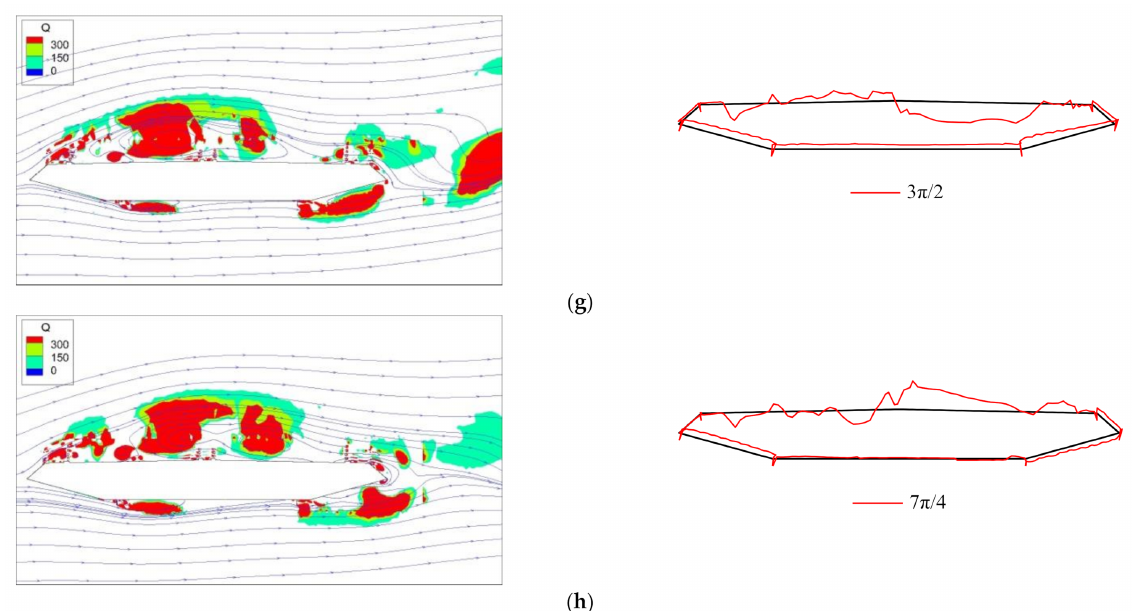
Figure 9. Distributed VIPs and vortex structures during one cycle of the stable stage of VIV. ( a ) 0 mo- ment. ( b ) π /4 moment. ( c ) π /2 moment ( d ) 3 π /4 moment. ( e ) π moment. ( f ) 5 π /4 moment. ( g ) 3 π /2 moment. ( h ) 7 π /4